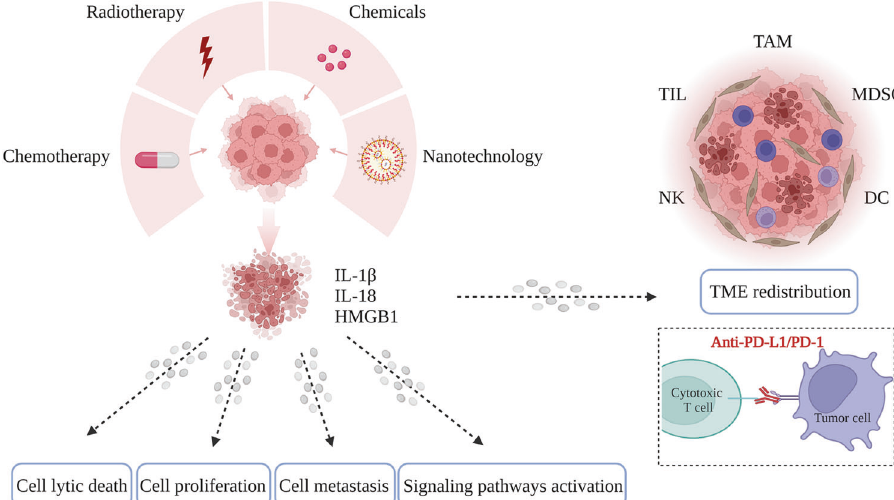
Fig. 2 The dynamic role of pyroptosis in breast cancer tumor development and treatment. Chemotherapy, radiotherapy, and several small molecule chemicals or medications can induce pyroptosis in breast cancer cells, which results in cell lytic death, regulates cell proliferation and metastasis, and activates signaling pathways. Moreover, pyroptosis in breast cancer cells also exerts a crucial role in TME redistribution and is expected to improve the ef fi cacy of